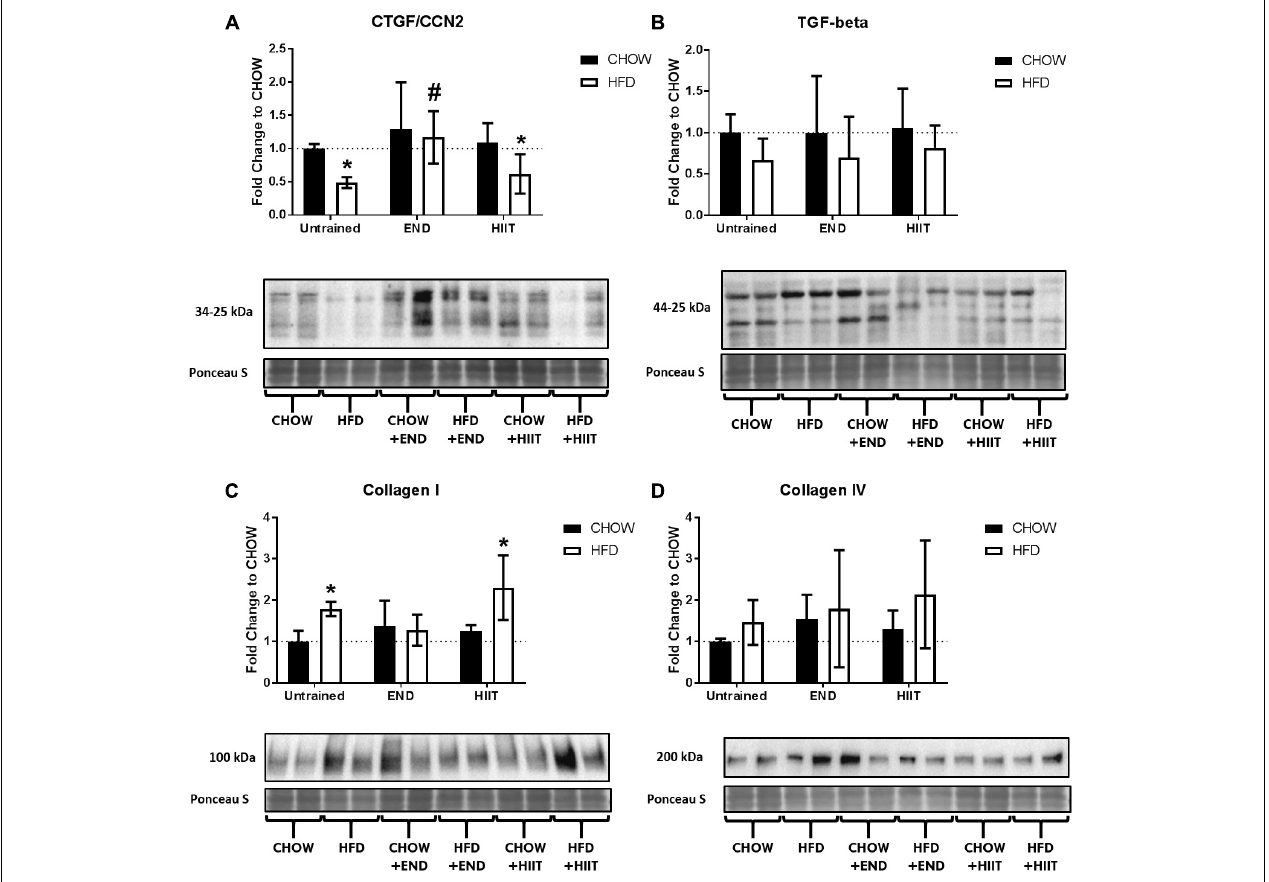
FIGURE 11 | Liver collagens and growth factors. Connective tissue growth factor/CCN2 (CTGF/CCN2; A ), transforming growth factor beta (TGF- β ; B ), collagen I (C) , collagen IV (D) , and their representative blots below its respective graph with its membrane stained with Ponceau S used as loading control. Data are presented as means ± SD and the number of animals in each group is 5–6. ∗ p < 0.05 vs. CHOW untrained; # p < 0.05 vs. HFD untrained by Two-way ANOVA with Tukey’s and Sidak’s post hoc